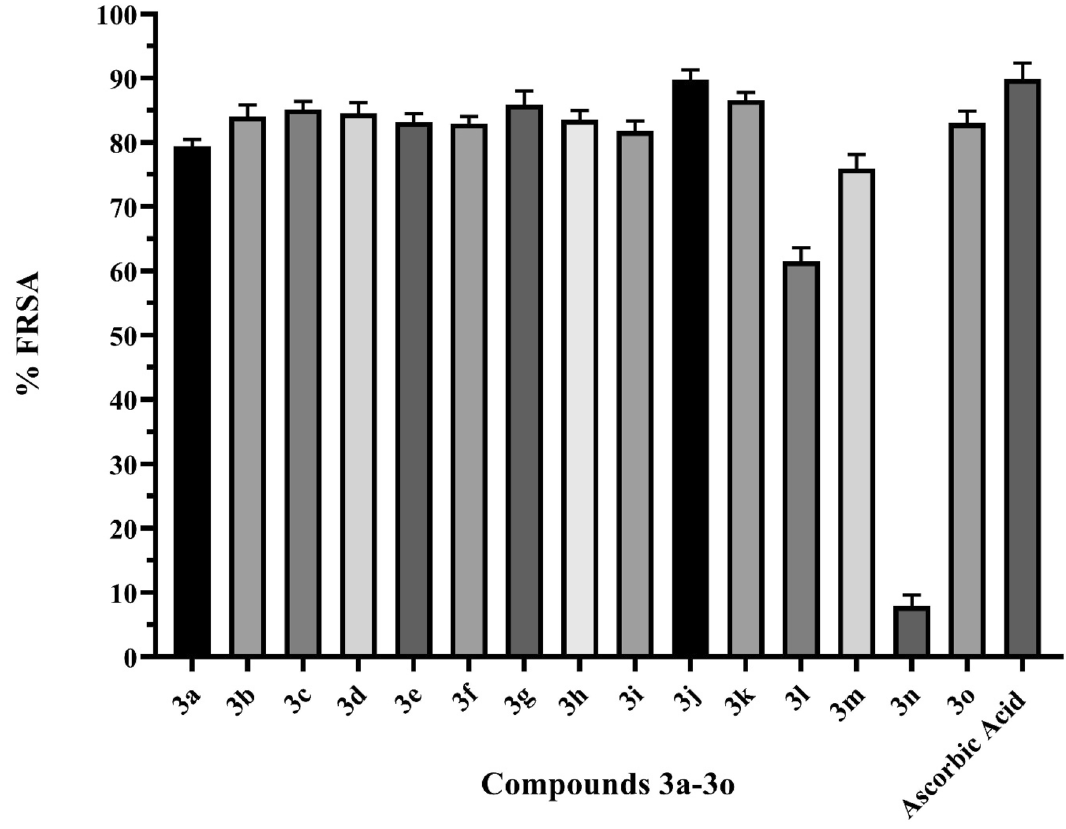
Figure 3. DPPH free radical scavenging activity (FRSA). Ascorbic acid was used as a positive control.